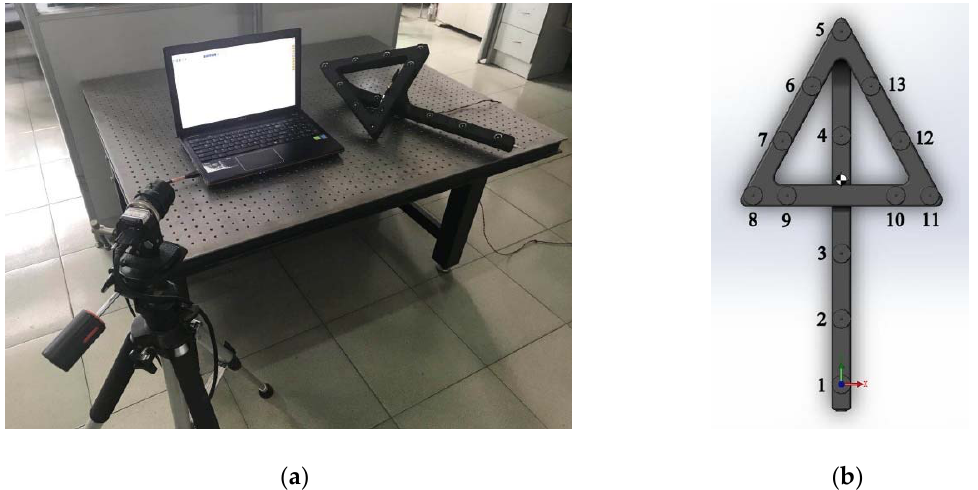
Figure 1. Introduction of light pen coordinate measuring system. ( a ) The typical composition of the light pen coordinate measuring system; ( b ) the light pen structure adopted in this paper.